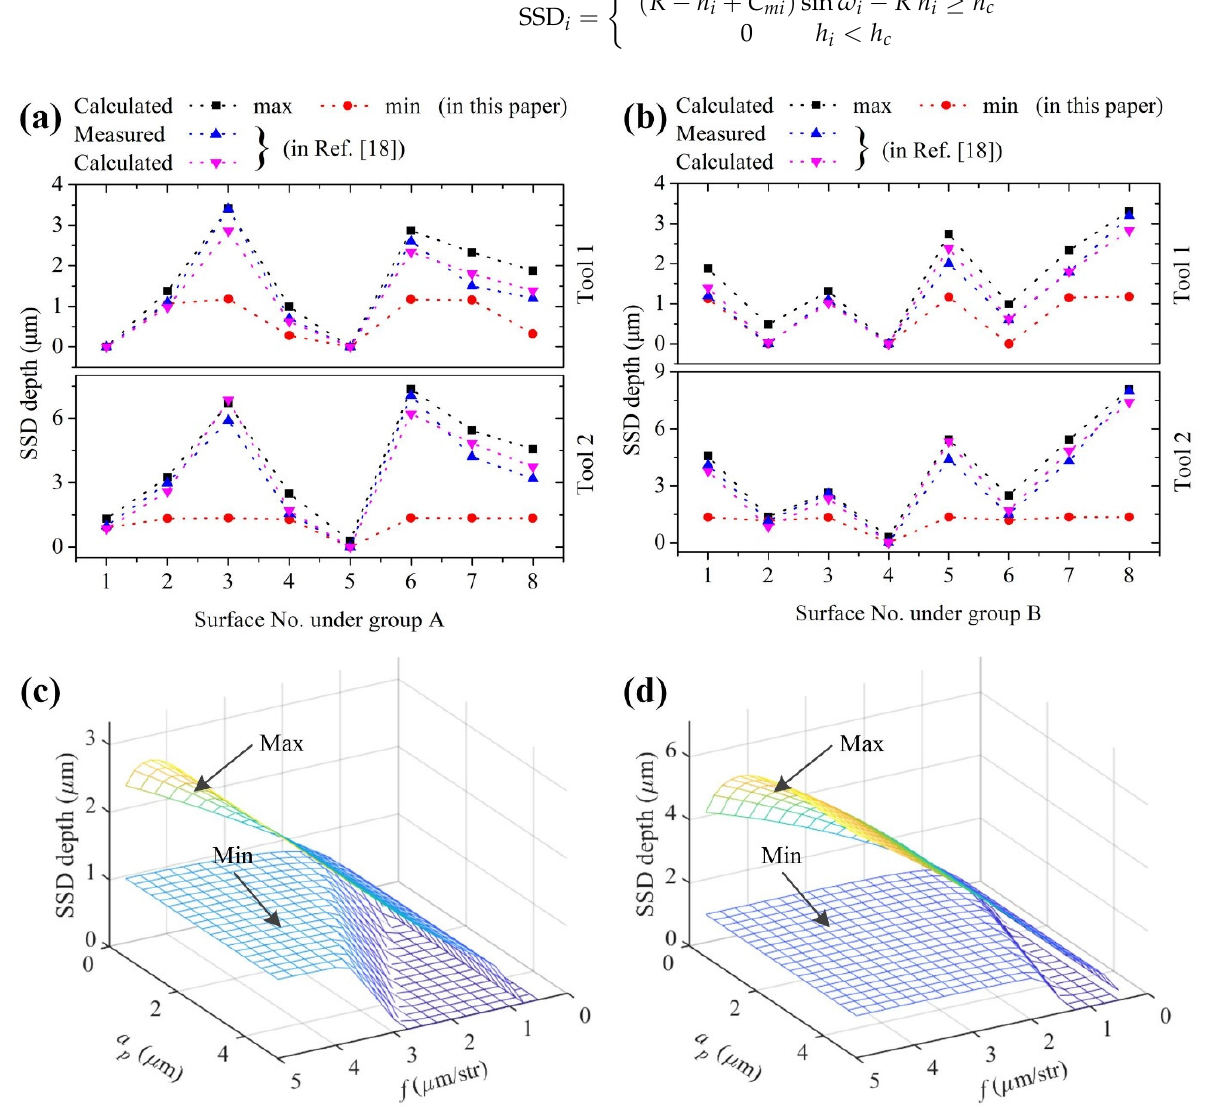
Figure 11. Measured and calculated SSD depths under ( a ) group A and ( b ) group B using tools 1 and 2; calculated SSD depths using ( c ) tool 1 and ( d ) tool 2 under a wider range of cutting parameters.